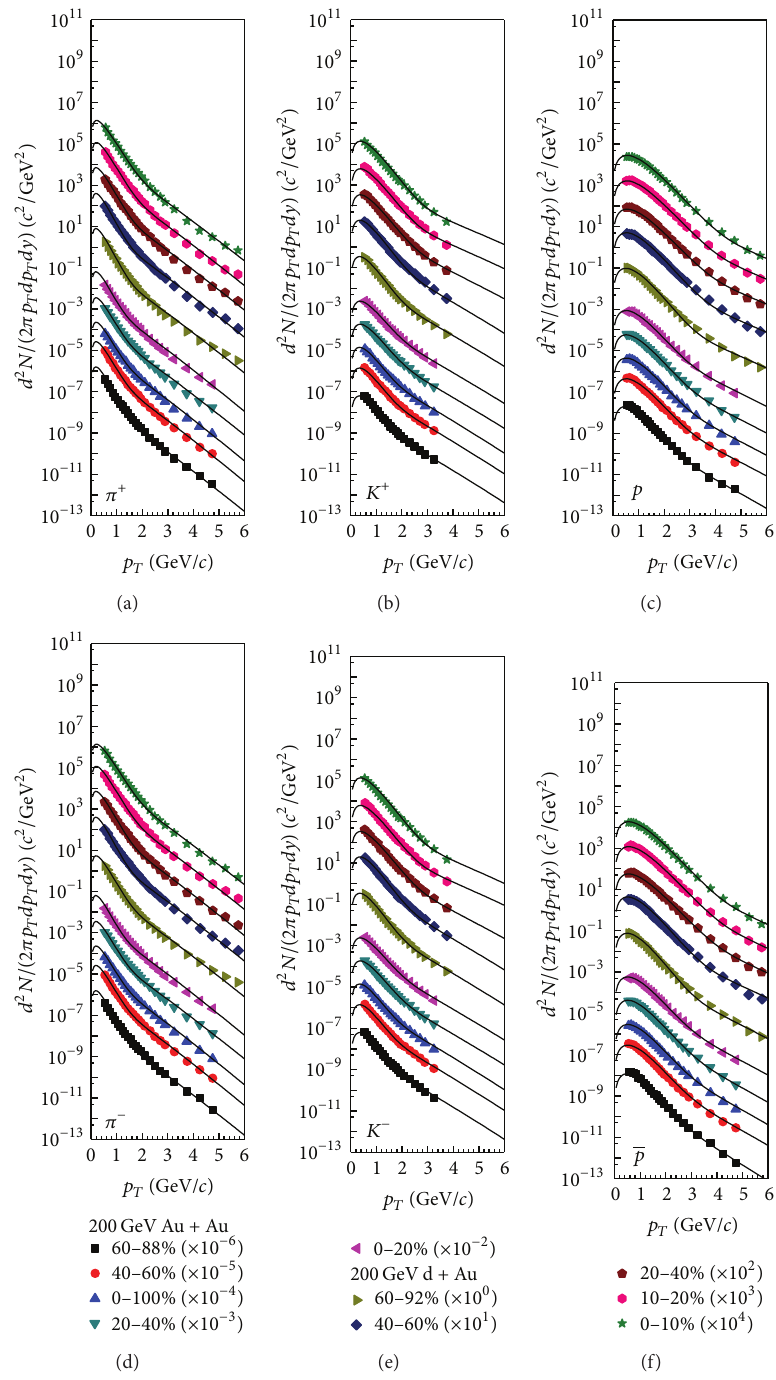
Figure 3: The transverse momentum distributions of positively and negatively charged particles in Au-Au and d-Au collisions at √𝑠 𝑁𝑁 = 200 GeV with different centrality classes and magnifications. The symbols represent the experimental data measured by the PHENIX collaboration [41], and the curves are our results calculated by the two-component revised Boltzmann